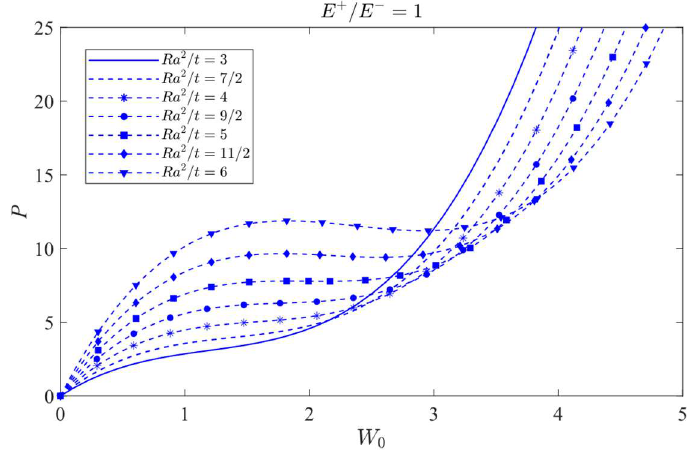
Figure 15. Load vs. central deflection when λ = 1/2 and E + / E − = 1.